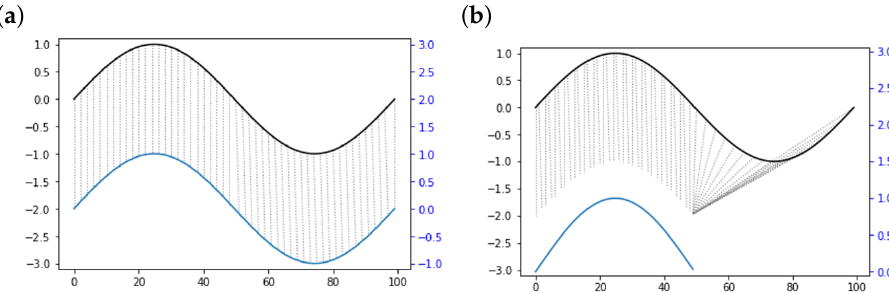
Figure 4. Comparison of points matching and feature matching. The abscissa is the time series sequence, and the ordinate is the time series value. ( a ) Points matching. ( b ) Feature